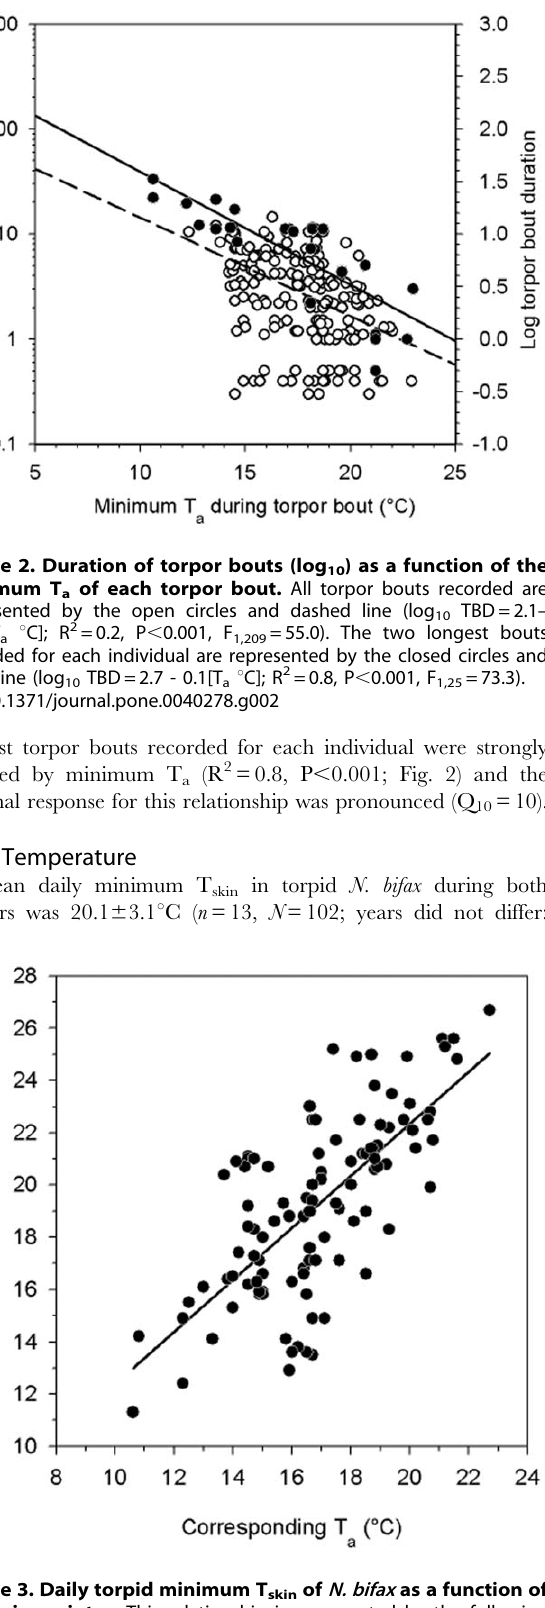
Figure 3. Daily torpid minimum T skin of N.bifax as a function of T a during winter. This relationship is represented by the following equation: minimum T skin ( u C) = 2.4 + 1.0[T a u C]; R 2 = 0.5, P , 0.001,